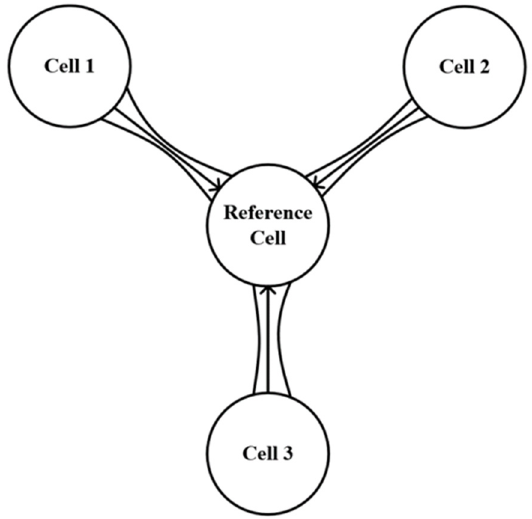
Figure 5. Reference diagram of multicellular formation position.